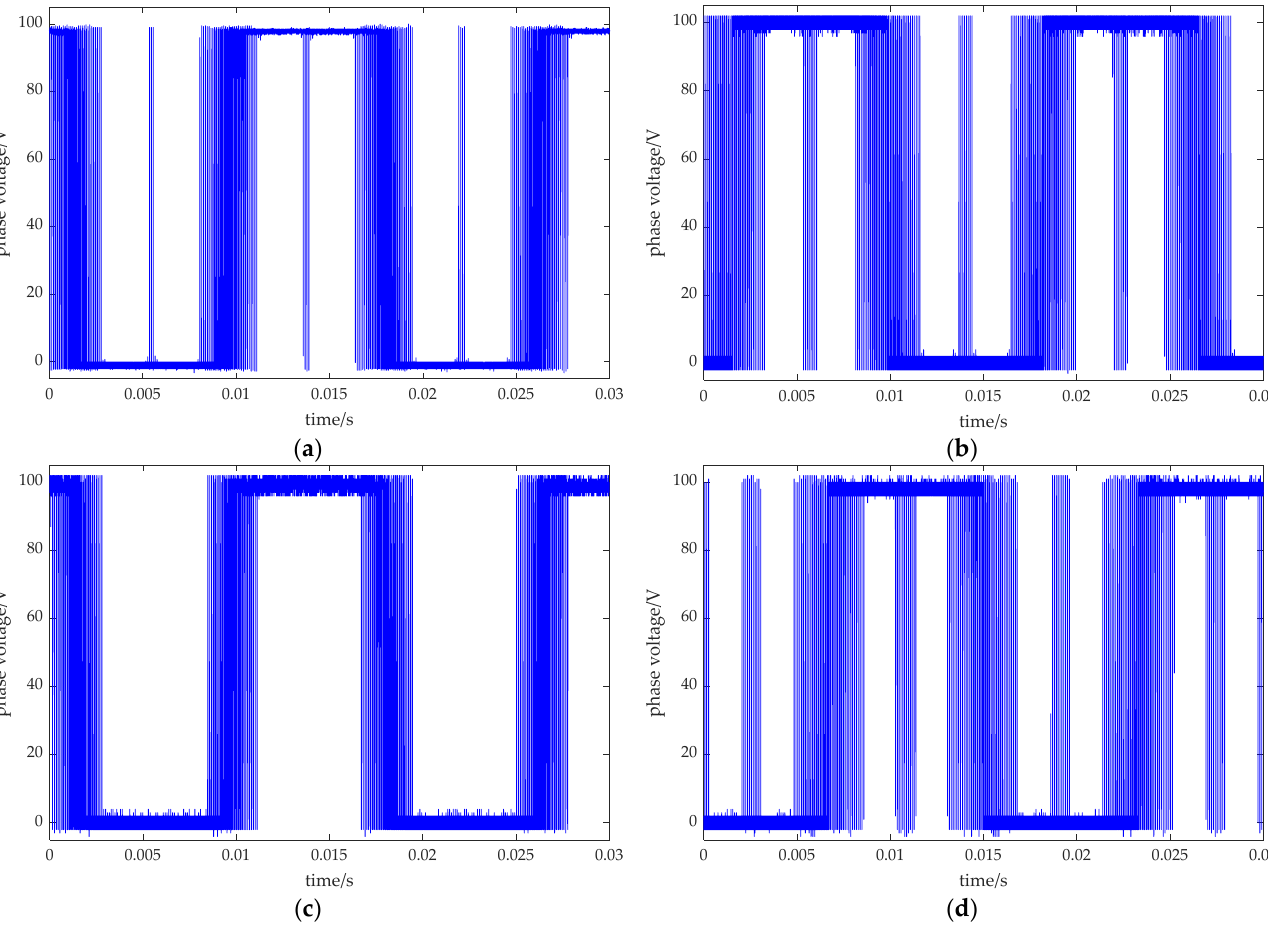
Figure 12. Experiment waveform of output phase voltage at m = 0.909: ( a ) strategy A; ( b ) strategy B; ( c ) strategy C; ( d ) strategy D.